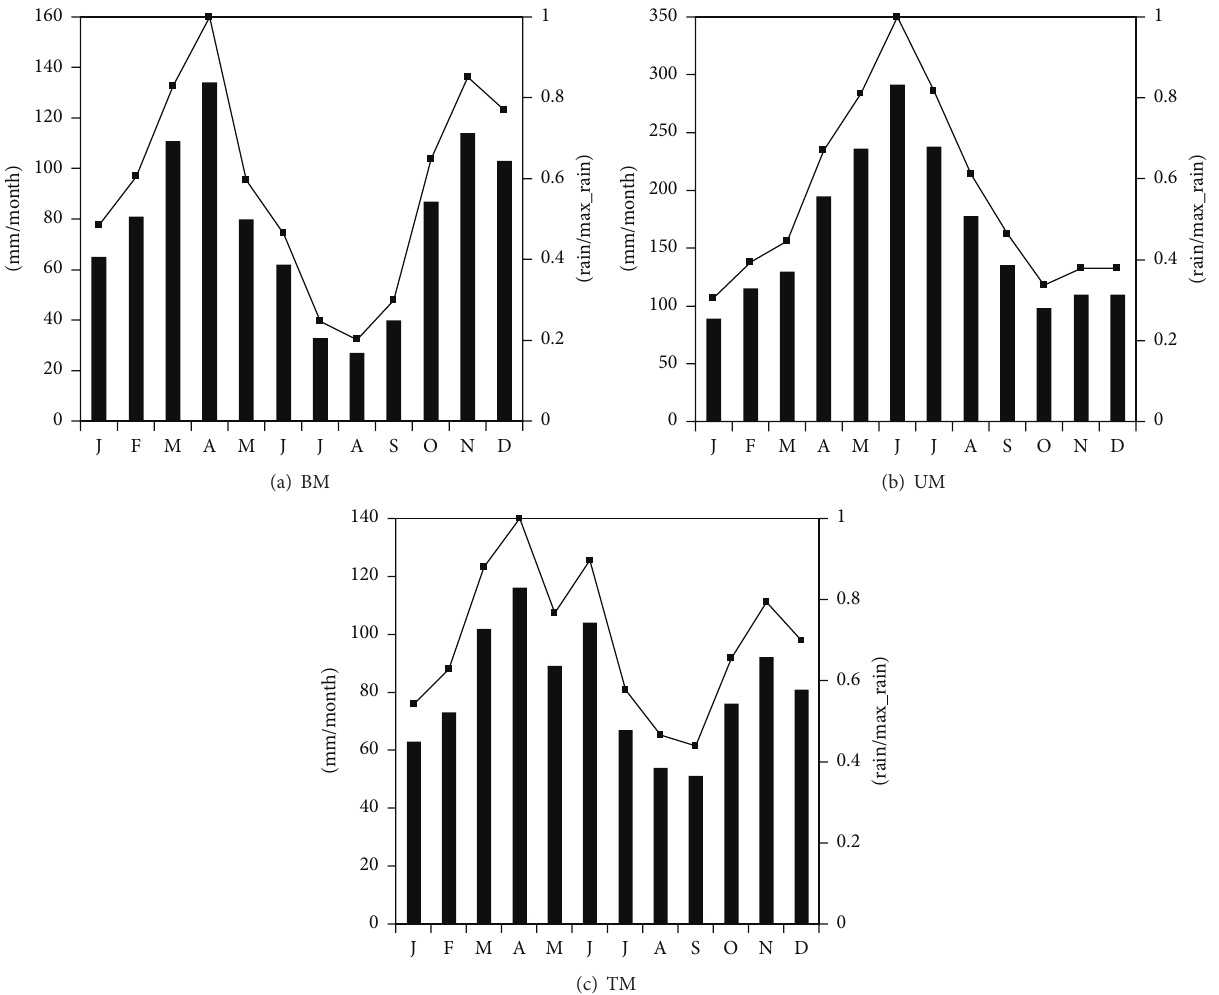
Figure 3: The three seasonal precipitation regimens, average monthly rainfall (left 𝑦 -axis) and normalized precipitation regimes (NPRs) (right 𝑦 -axis). (a) Bimodal regime, (b) unimodal regime, and (c) three-modal